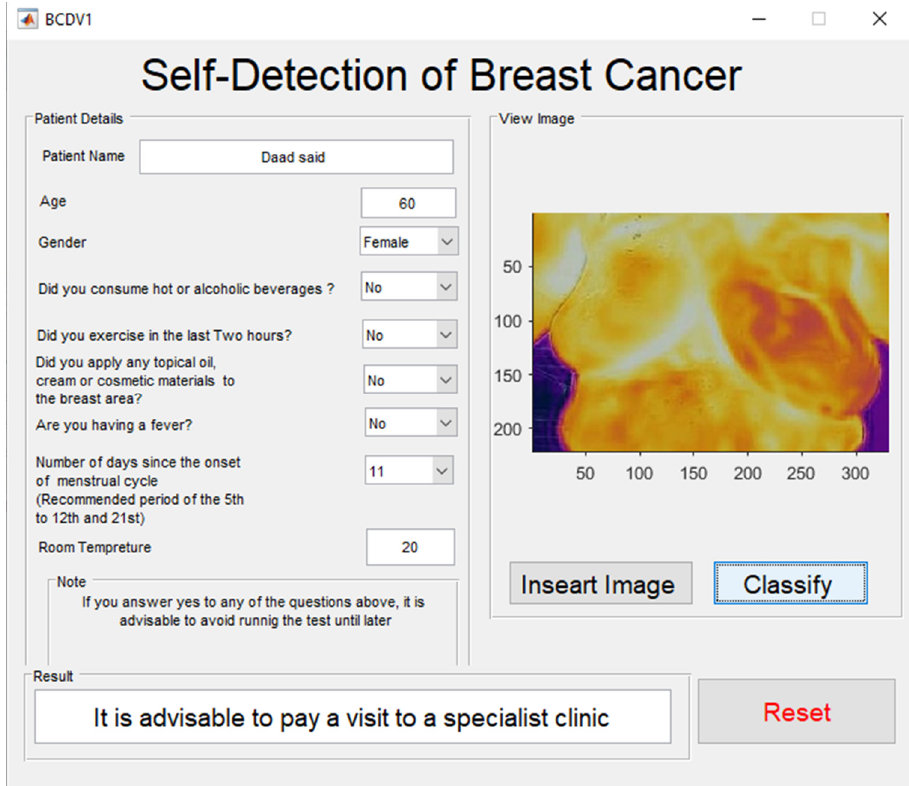
Figure 9. Thermal Image from Shiraz Medical Center for breast cancer.